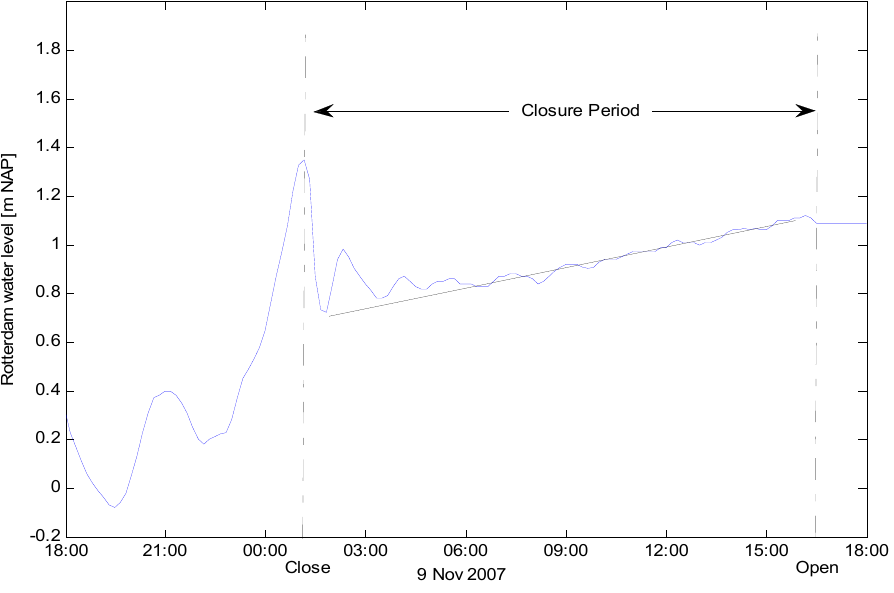
Figure 9. The operation control of the Maeslant